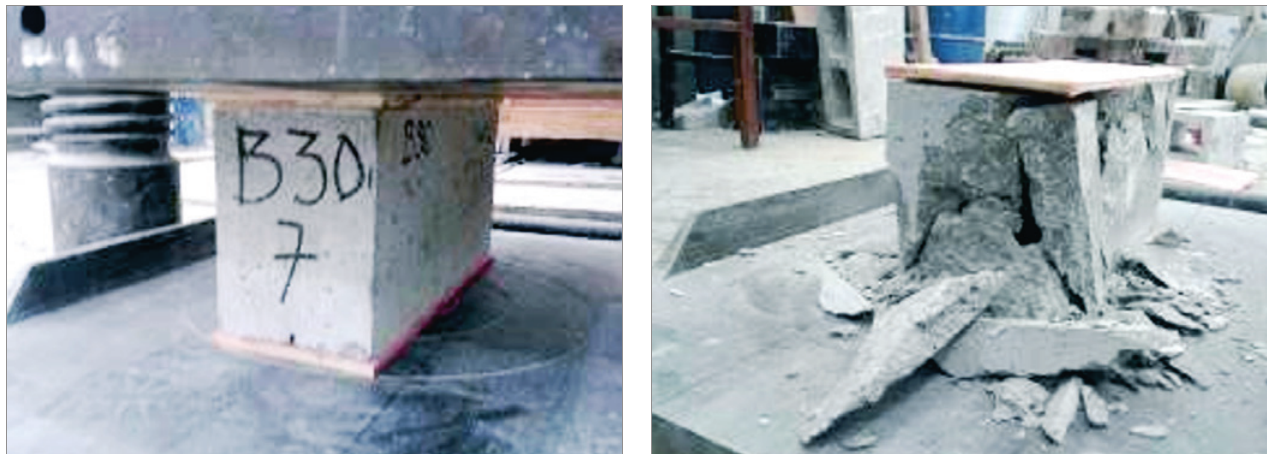
Ensaios dos blocos de concreto